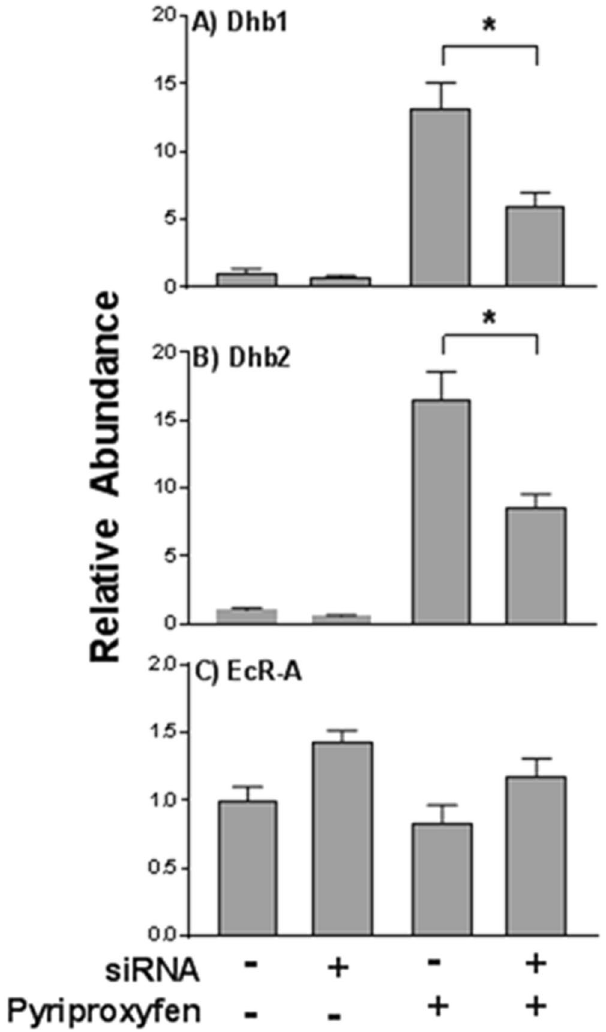
Figure 3. Relative abundance of Dhb1 ( A ), Dhb2 ( B ), and EcR-A ( C ) mRNA in D . magna provided L4440 vector or L4440 vector expressing Dhb2 siRNA with or without pyriproxyfen treatment. Data are presented as the mean and standard deviation (n = 3). Results for each gene are normalized to the control (no siRNA and pyriproxyfen). An asterisk denotes a significant ( p < 0.05) difference between the connected data (One-way Analysis of Variance, Tukey’s Multiple Comparisons